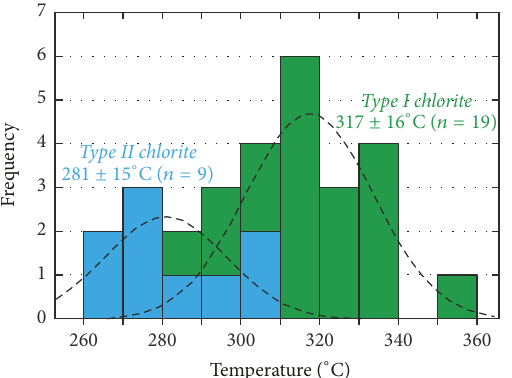
Figure 9: Histogram showing ranges of calculated temperature values of two types of chlorite in Haisugou.